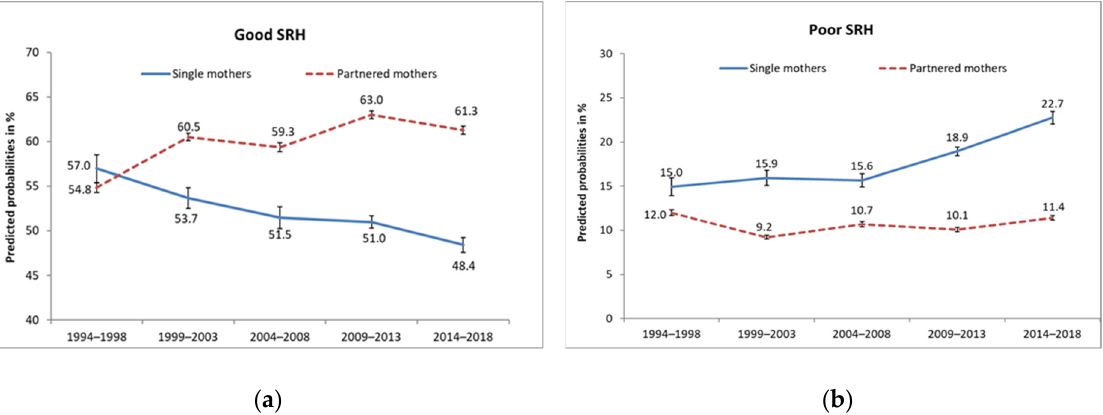
Figure 1. Predicted probabilities and standard errors of ( a ) good and ( b ) poor SRH from 1994–1998 to 2014–2018 in single and partnered mothers, Germany, adjusted for age. Table 4. Development of good/poor self-rated health (SRH) in single and partnered mothers aged 30–49 years in Germany, 1994–2018.